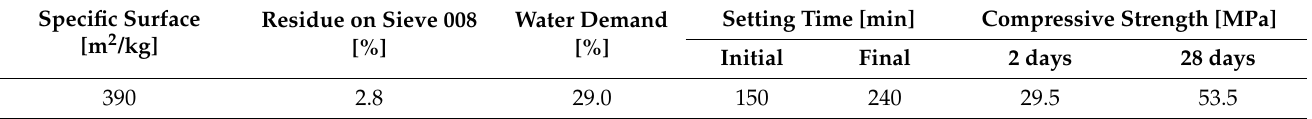
Table 1. Physical and mechanical properties of Portland